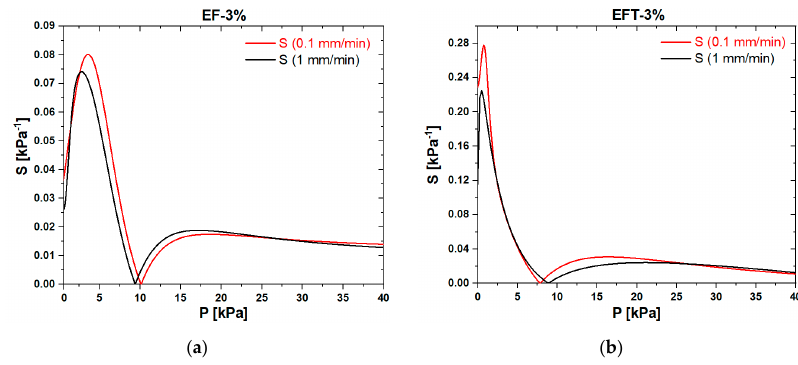
Figure 13. Sensitivity of samples EF-3% ( a ) and the EFT-3% ( b ) at two different crosshead